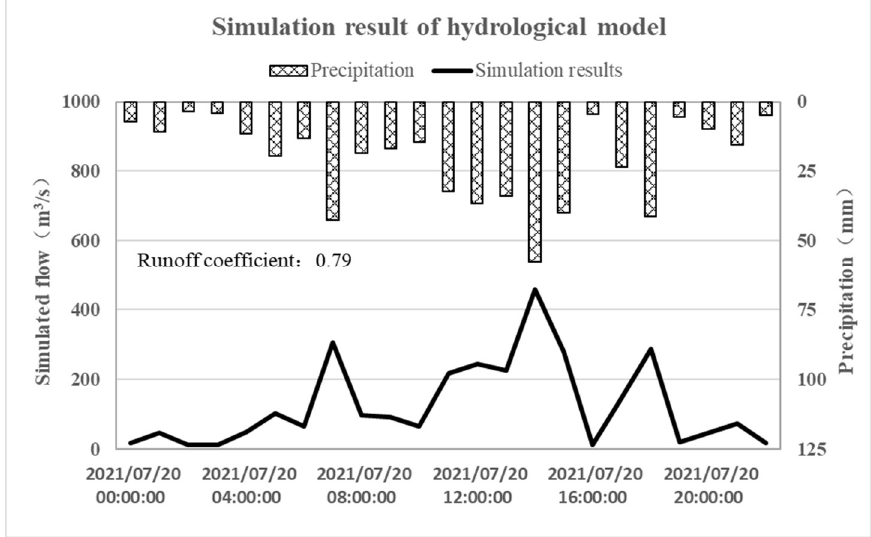
Figure 8. Simulation results of Wangzongdian watershed.